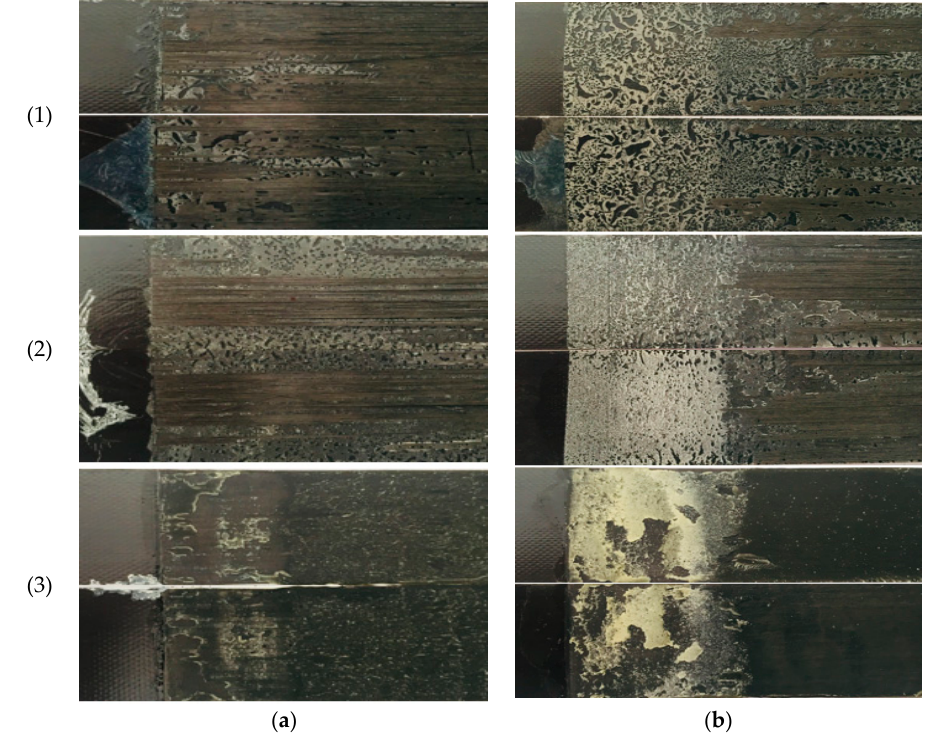
Figure 3. Fracture surfaces of the three adhesive joints. ( a ) Mode I: (1) Loctite® EA 9470 TM , (2) Araldite® 2015, (3) 3M TM DP8010NS. ( b ) Mode II: (1) Loctite® EA 9470 TM , (2) Araldite® 2015, (3) 3M TM